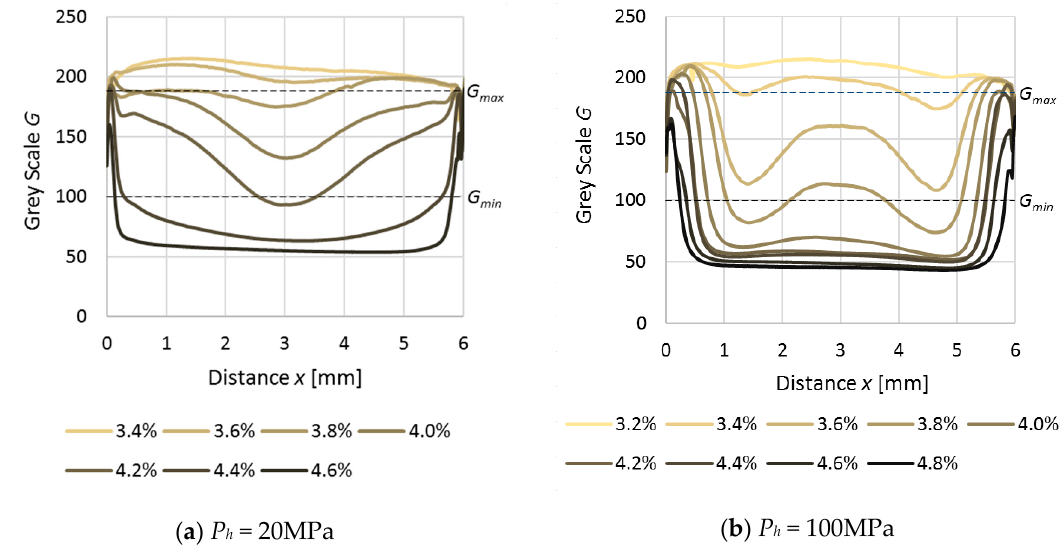
Figure 5. Grey scale G in relation to distance from the edge for samples produced with different holding pressures: ( a ) 20 MPa and ( b ) 100 MPa.